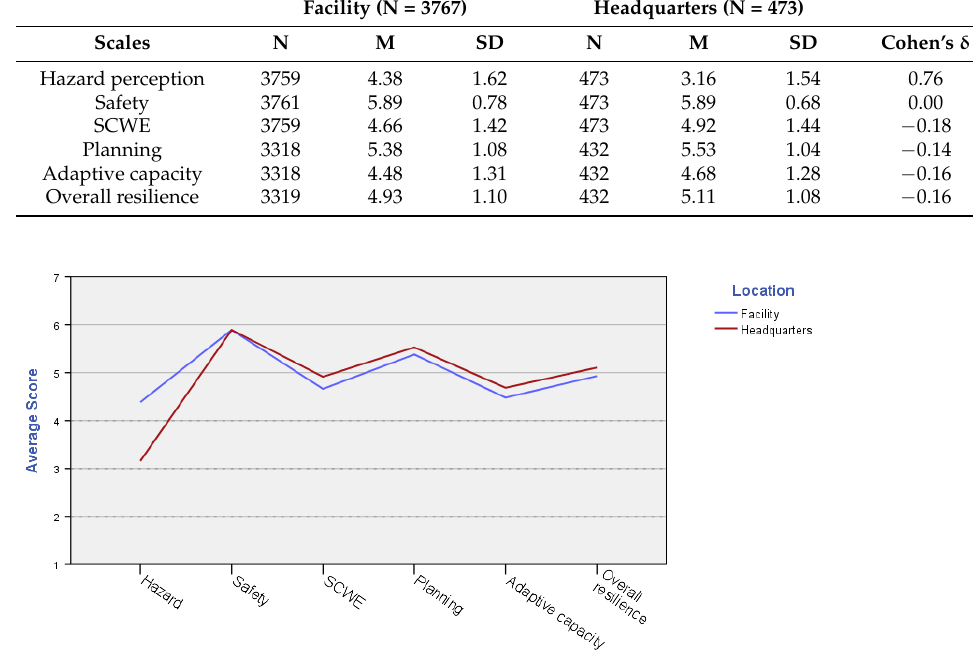
Table 9. Descriptive statistics of the BARS by work location.